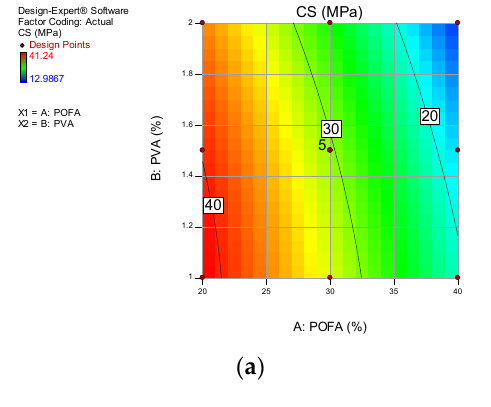
Design-Expert® Software Factor Coding: Actual TS (MPa) Design points above predicted value Design points below predicted value 7.294 3.067